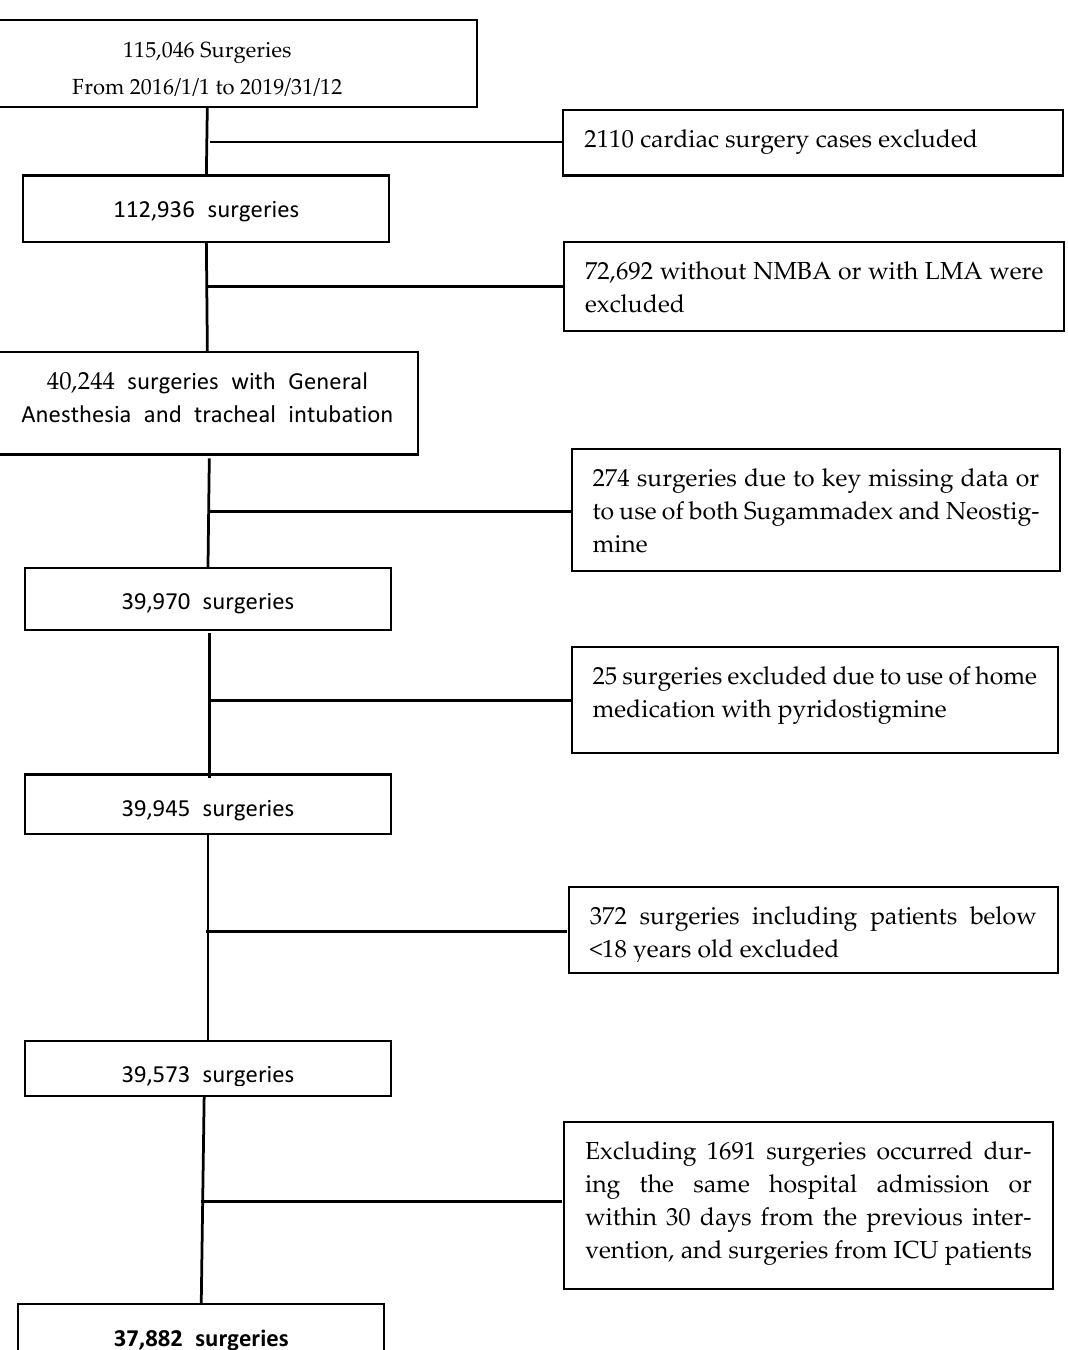
Figure 1. Flow chart of patient selection process. Time-trend results are reported in Table 2. Other baseline characteristics, includ- Males comprised 44.5% (16,256) of the population, and the median age was 57 (IQR ing age and gender, did not have a clinically meaningful difference over time. Baseline 45–69) years. There were no significant variations in population baseline characteristics characteristics and data by year for patients on rocuronium are reported in Figure over 4 years, while the number of surgeries progressively increased from 8350 in 2016 to lowed by neurosurgery (22%), thoracic surgery (15%), and uro-gynecological procedures (14.5%). Hypertension was the most common baseline comorbidity (47.2% of cases), fol- lowed by diabetes (9.3%) and chronic obstructive pulmonary disease (COPD) (8.0%).